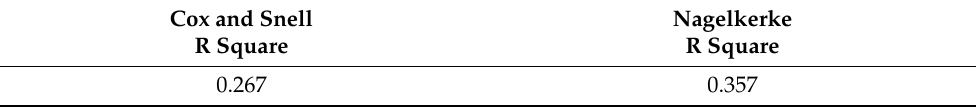
Table 4. Variance of child vaccination.